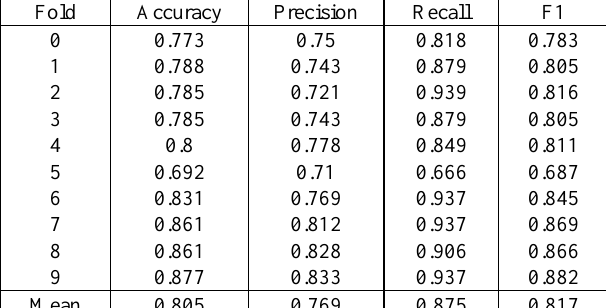
Figure 4 . Fire susceptibility map from the ensemble model.